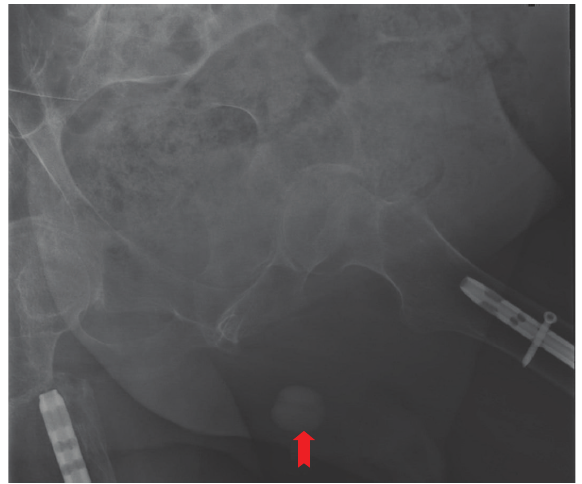
Figure 2: X-ray of pelvis was taken after injecting two mL of contrast through balloon channel of Foley catheter. The Foley balloon was located in scrotum (arrow) and not inside urinary bladder. Figure 3: X-ray of pelvis: twenty mL of contrast was injected thorough lumen of Foley catheter. Proximal urethra was visualised by the injected contrast (arrow) thus confirming that the tip of Foley catheter was lying in urethra and not in the bladder. There was large amount of urine retained in the bladder.